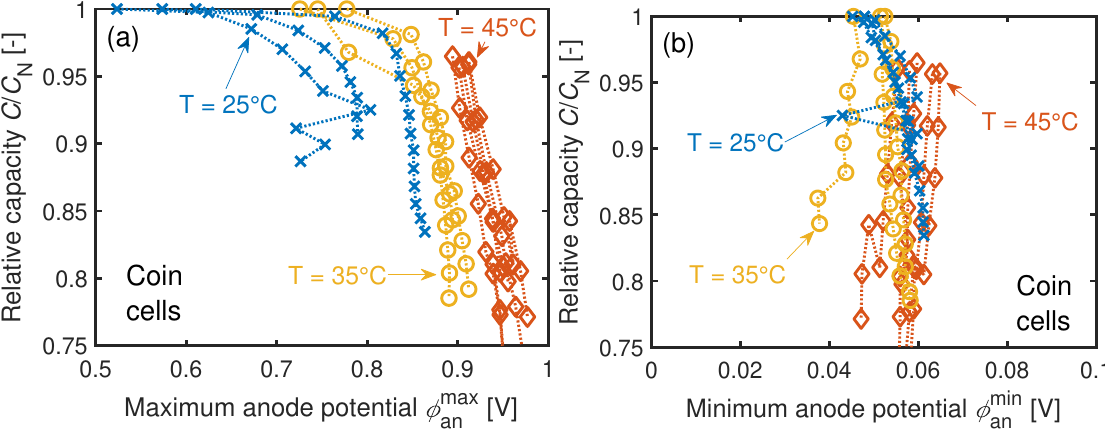
Figure 9. ( a ) Maximum and ( b ) minimum anode potentials of the C/3 capacity reference cycles during cyclic aging. The data points at 0cycles are missing for the T = 45 ◦ C